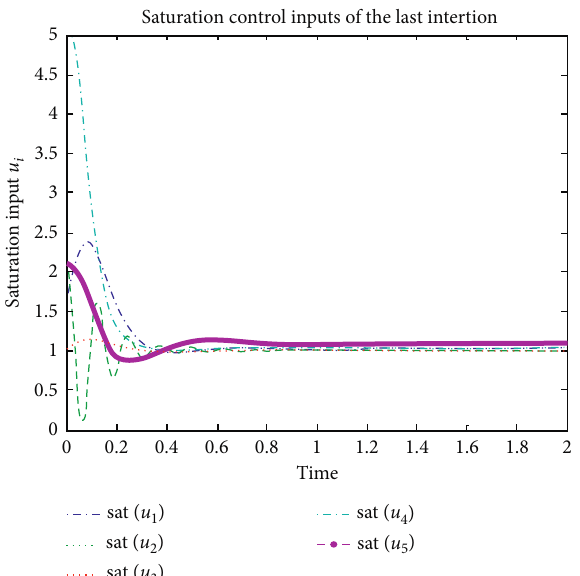
Figure 4: Saturation control inputs of the last iteration.